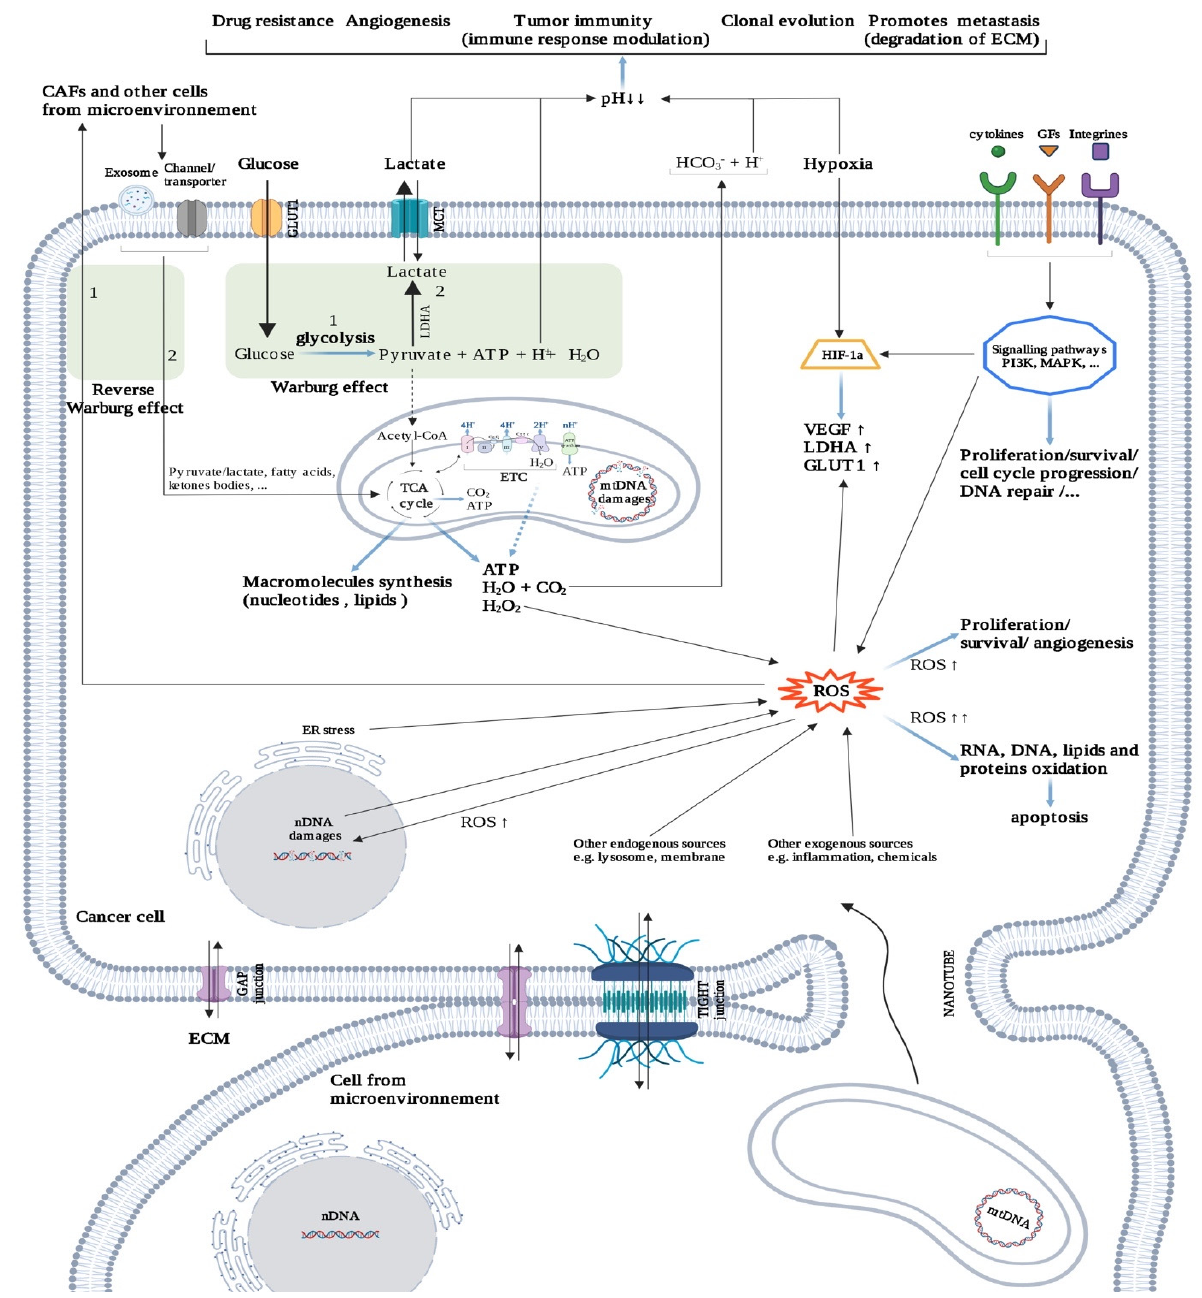
Figure 4. Cancer metabolism. Intercellular communication is facilitated by gap and tight junctions, but also by nanotubes, exosomes, and interleukins. Cancer cell metabolism mainly uses glucose through the Warburg effect, which increases acidosis in the tumor microenvironment (TME). Acidosis triggers several mechanisms for tumor survival. Under hypoxia conditions, the cancer cell can restart the oxidation chain (TCA cycle; Krebs cycle, ETC; electron transport chain) in several ways (e.g., reverse Warburg effect, mitochondrial transfer). Hypoxia promotes the formation of ROS, which play, depending on their concentration, a variety of roles in tumor progression (positive and negative). Created with BioRender.com (accessed on 2 January 2021).